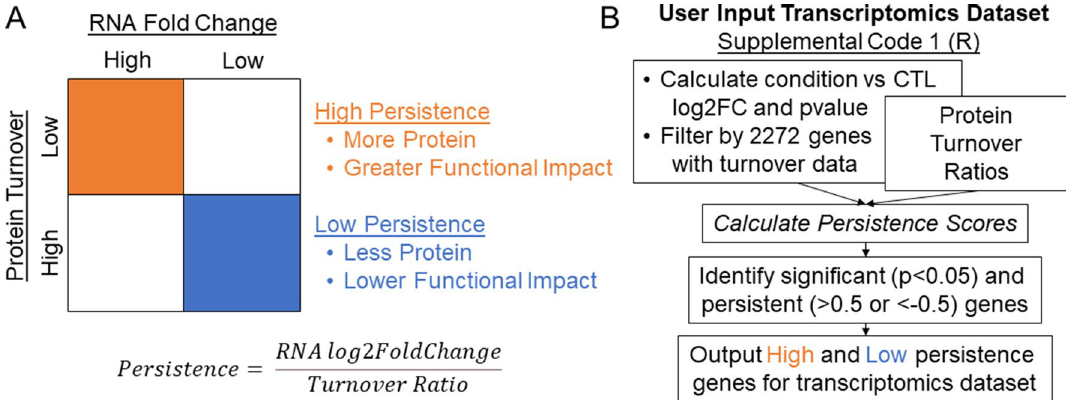
Figure 2. Schematic of persistence concept and analysis. ( A ) Conceptual framework for persistence, which considers protein turnover and RNA fold change together to gain a deeper understanding of the functional impact of changes in gene expression by estimating changes in protein expression. High persistence genes (orange) are thought to have a greater functional impact because they are produced more (high RNA expression) and remain in the cell longer (low protein turnover). Low persistence genes (blue) are thought to have a lesser functional impact because they are not produced as much (low RNA expression) and are cleared from the cell faster (high protein turnover). In this way, the persistence formula considers protein turnover and RNA fold change together and generates persistence scores provide deeper functional insights into RNA changes by acting as a proxy for protein changes. ( B ) Outline of code used to produce persistence scores and identify genes of high or low persistence. See Supplemental Code 1 for more details.